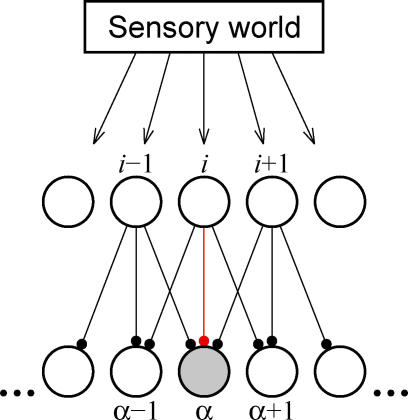
The author describes a computational model in which sensory information is received by one set of neurons (i) and transferred to another set (α), which control behavior.